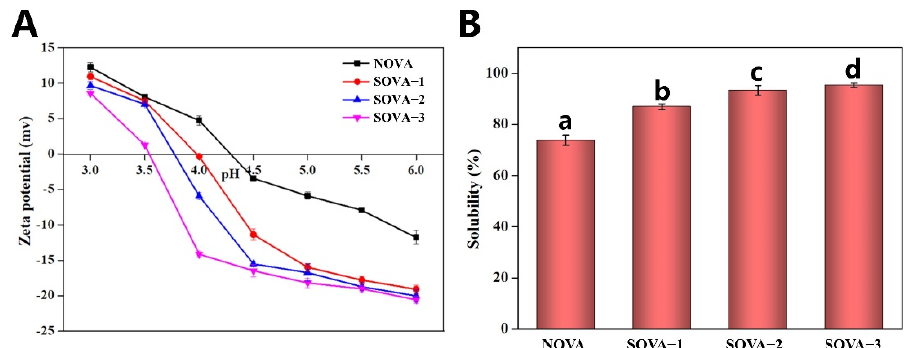
Figure 4. Zeta potential ( A ) and protein solubility ( B ) of OVA with different succinylated degrees. Different letters above the bars indicate significant differences ( p < 0.05).